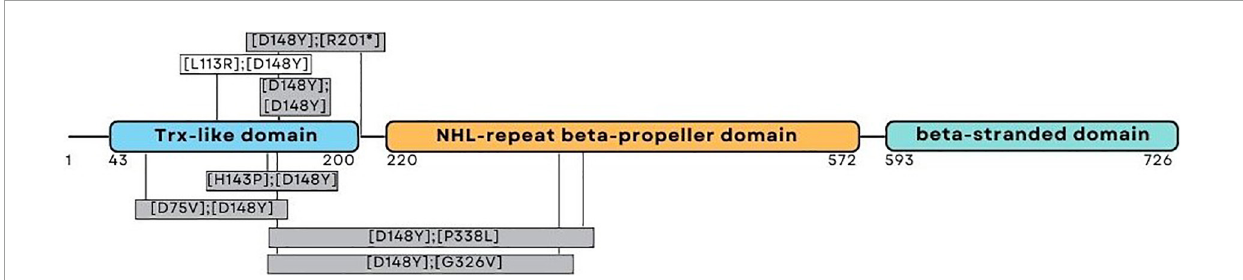
FIGURE1 Schematic representation of the NHLRC2 domain composition and amino acid substitutions identified from the FINCA patients. The patients reported here harbored variants presented above the corresponding domain; the variants presented in gray boxes have been described previously (Uusimaa et al., 2018; Brodsky et al., 2020; Rapp et al., 2021; Badura-Stronka et al., 2022).